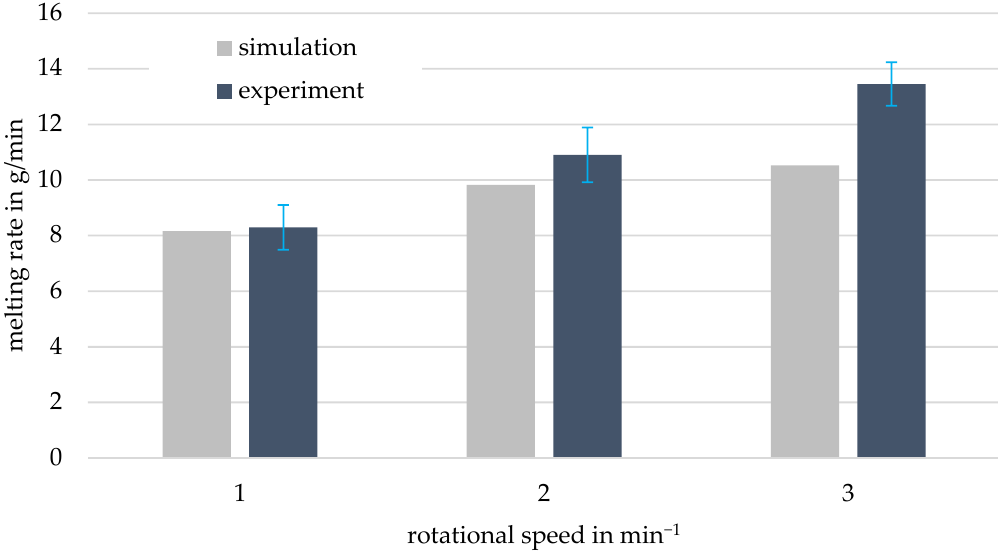
Figure 7. Calculated and experimentally measured melting rates for different rotational speeds at a stamp force of 1000 N and a ring temperature of 200 °C.